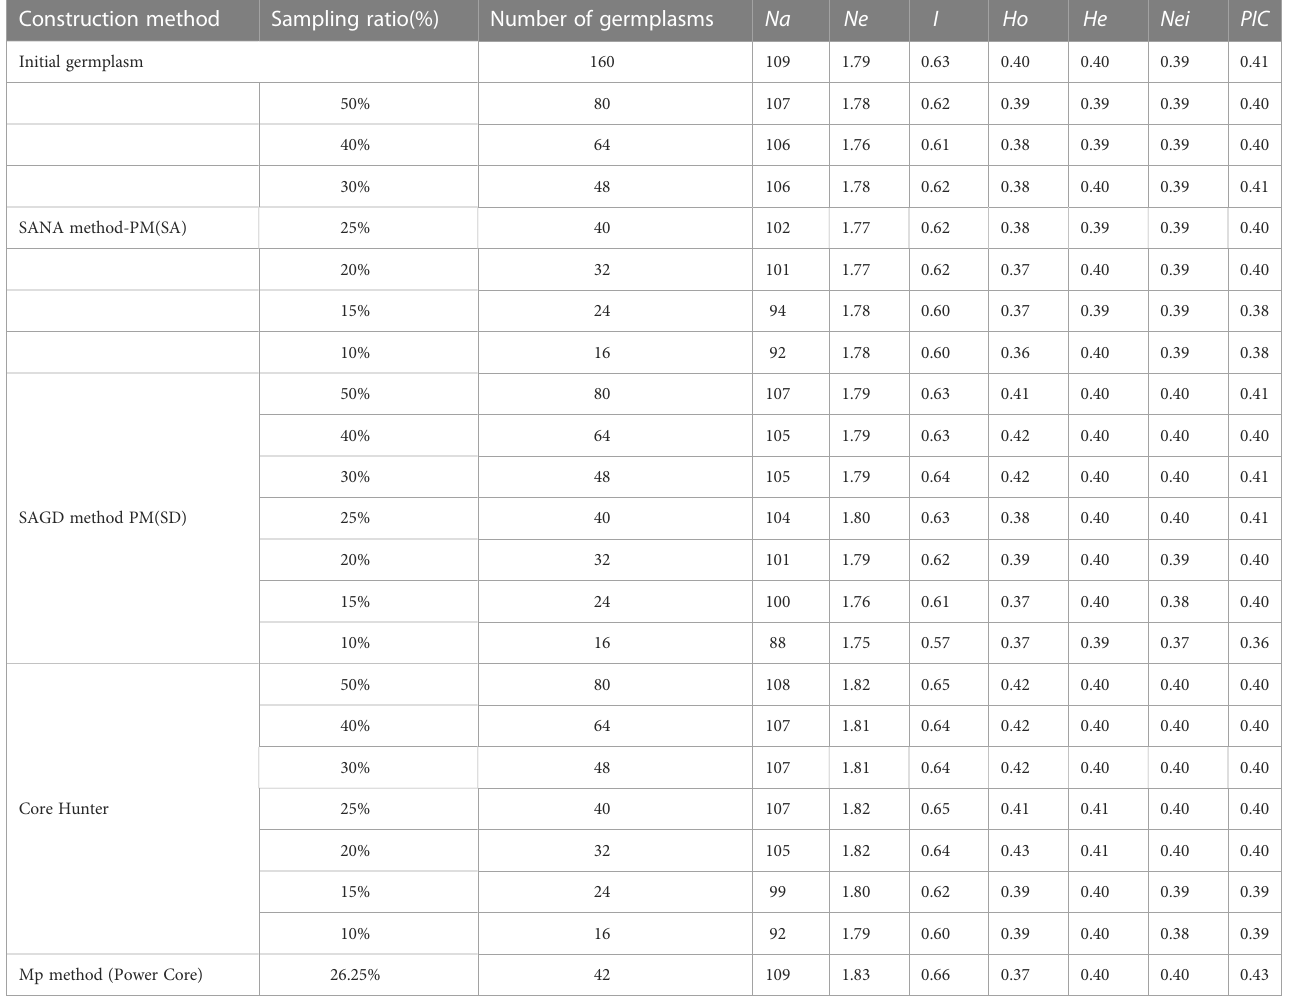
TABLE 2 Variability parameters for colored calla lily with the different core subsets. Construction method